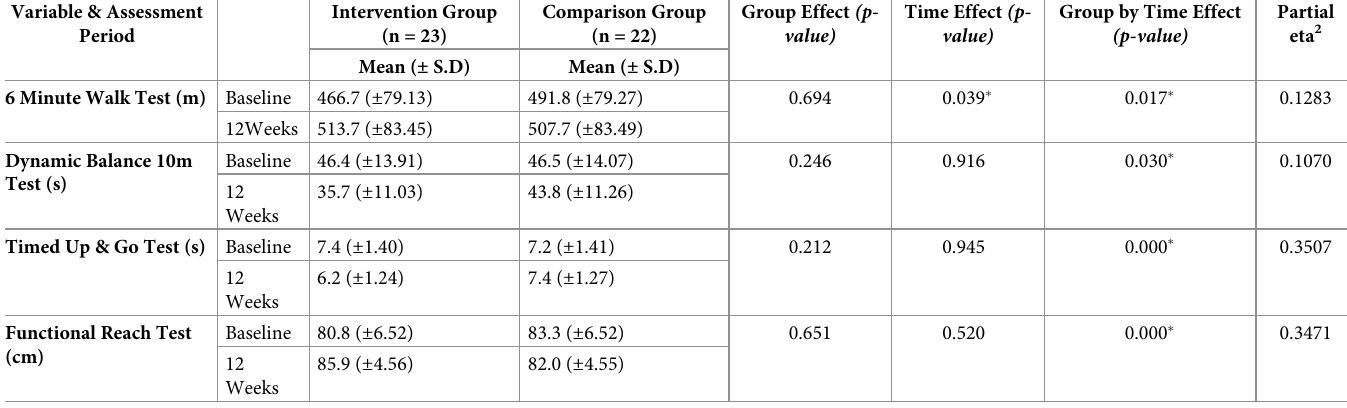
Table 7. Changes in functional ability in the intervention and comparison